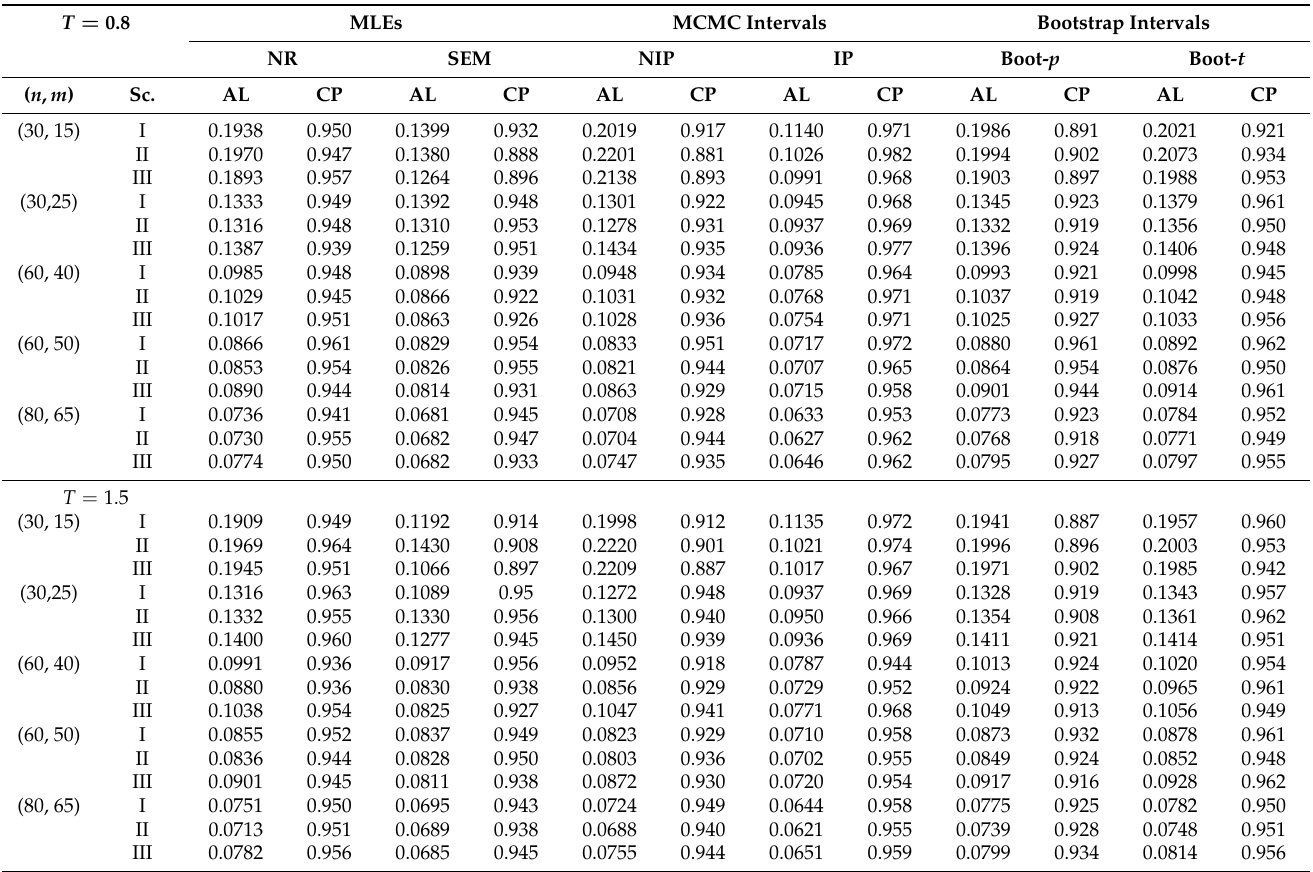
Table 12. 95% CI’s, average length (AL) and coverage percentage (CP) of approximate, Bayes and bootstrap confidence intervals of θ 1 under informative prior (IP) and noninformative (NIP) prior, for different schemes with different values of n and m, when ( θ 1 , θ 2 , λ ) =(0.05, 0.06,